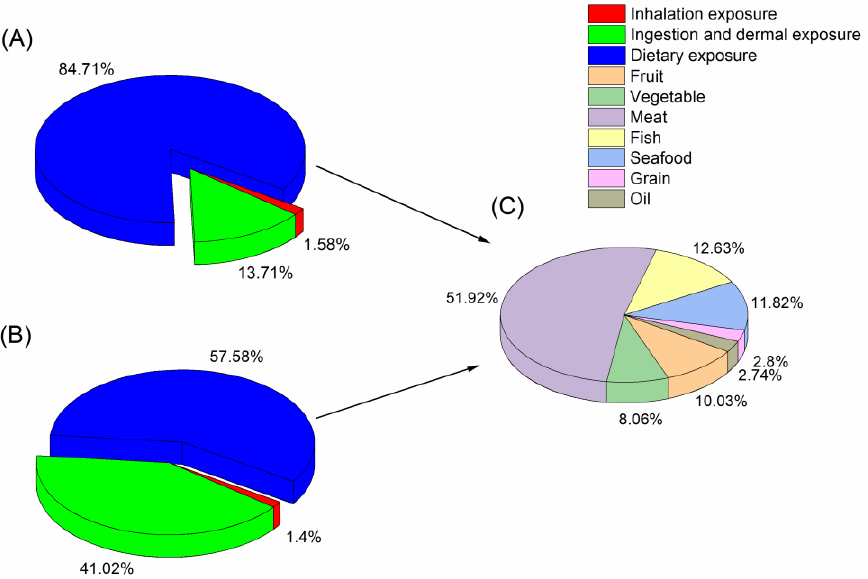
Figure 6. Contribution of SCCPs intake via three main exposure routes. ( A ) Estimated daily intake (EDI) of SCCPs for adults. ( B ) EDI of SCCPs for children. ( C ) The relative contribution of various foods to dietary exposure.